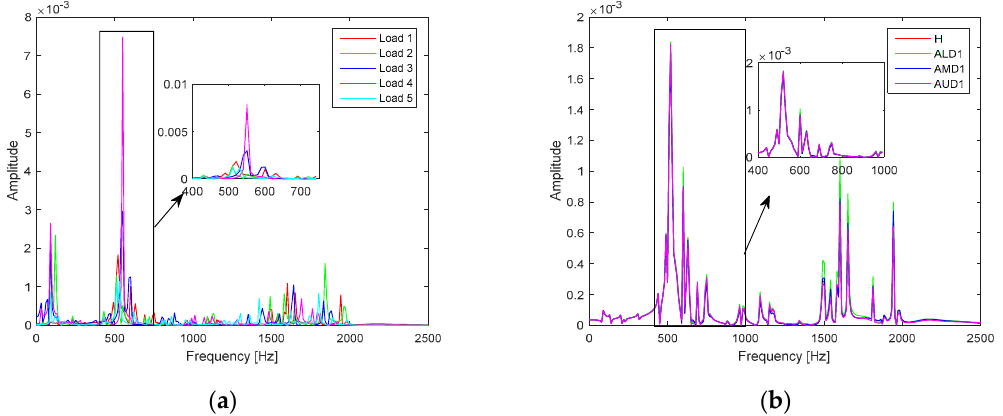
Figure 2. Frequency spectrum of the transient response for: ( a ) a single case ( AL1 ) to 5 random loadings; ( b ) Healthy and different delaminated cases to a single random load.